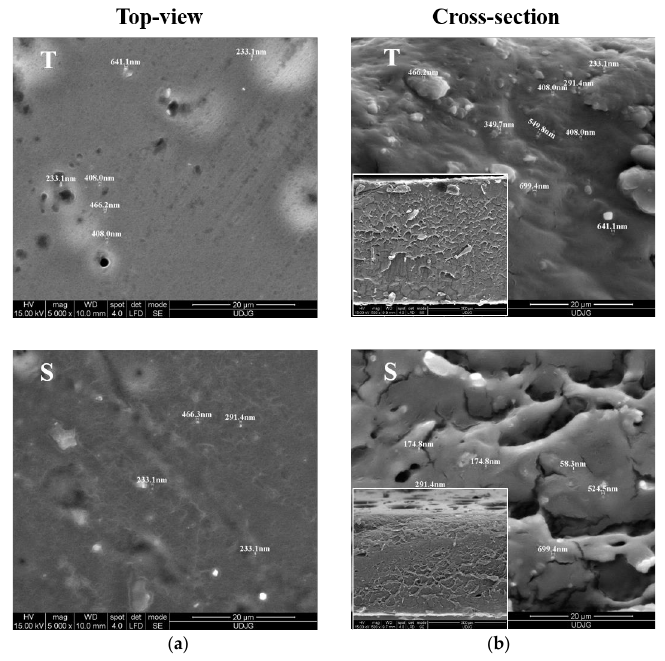
Figure 3. SEM micrographs (20 µm scale bar) of: ( a ) top-view; and ( b ) cross-section presenting the spherical morphology and uniform size distribution of thyme EOs with T & S nanoemulsions.